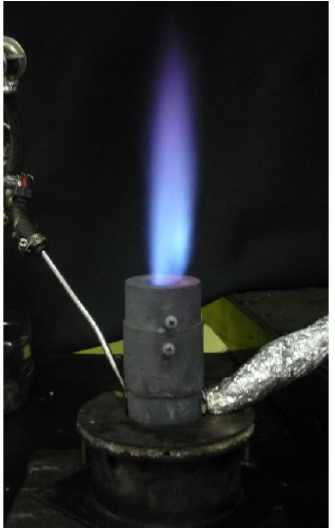
Figure 1. Heptane combustion in the experimental burner.